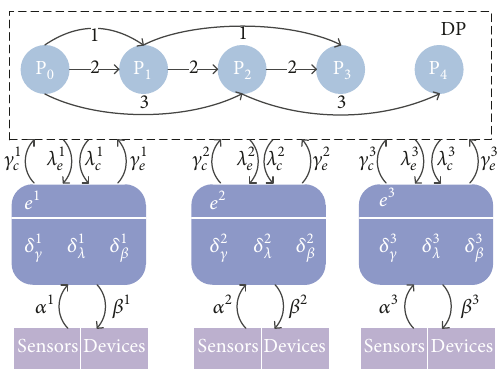
Figure 4: The BSIS model process. 𝜆 is the response, and 𝛾 is the request. 𝛼 and 𝛽 are the input and output of the ePLC, respectively. 𝑃 s is the set of all programs in the cloud. 𝛿 s is the set of